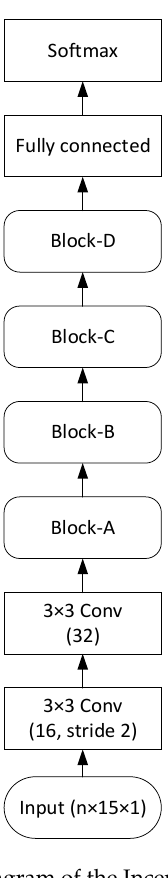
Figure A1. Diagram of the Inception network.